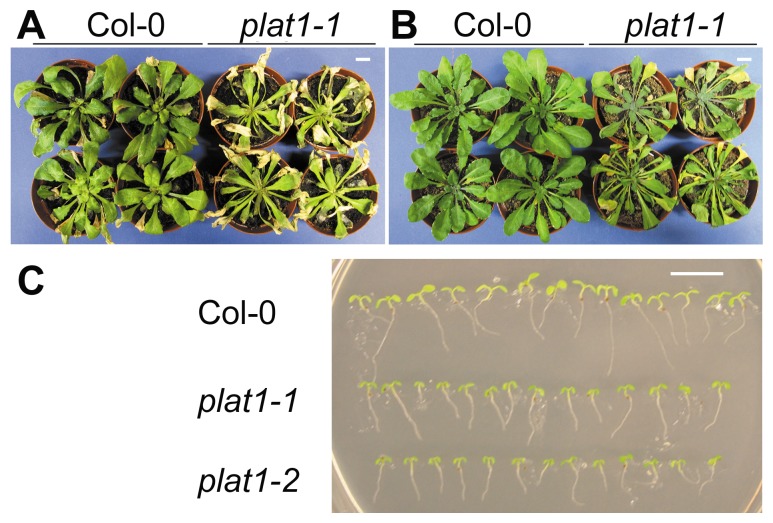
PLAT1 loss-of-function reduces abiotic stress tolerance.(A) Salt stress tolerance in wild-type (Col-0) and plat1-1 seedlings irrigated with 200 mM NaCl for 14 d. n≥10 (B) Drought stress tolerance in wild-type and plat1-1 seedlings, following 14 d without watering. n≥10 (C) Cold stress tolerance in 7-d-old wild-type, plat1-1 and plat1-2 seedlings following 14 d of incubation at 8°C. n = 14. Scale bar = 1 cm.